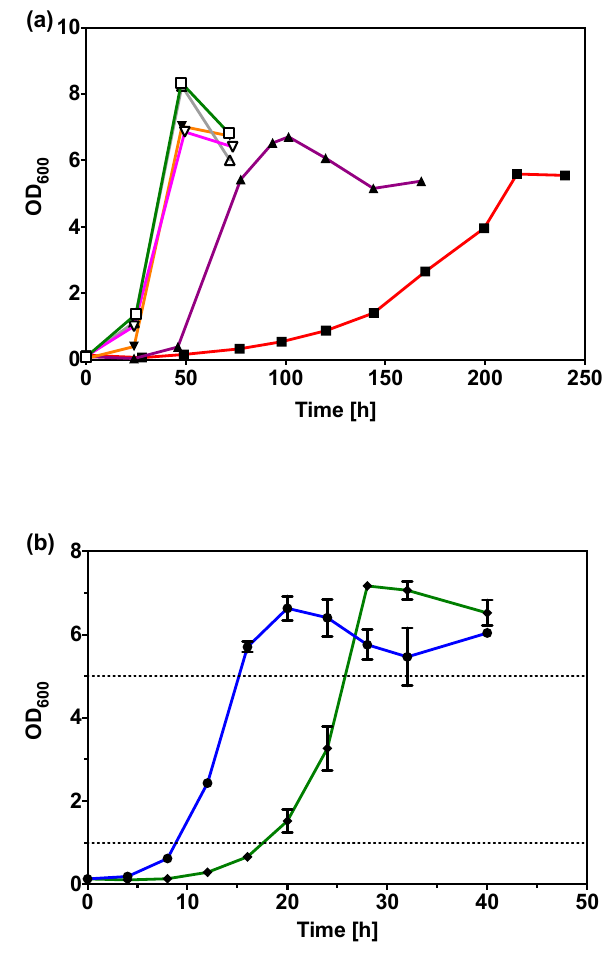
Figure 2. ( a ) Growth curves of C. necator H16 in the six serial passages during adaptive evolution; Round 1 (red line; solid square), Round 2 (purple line; solid triangle), Round 3 (orange line; solid inverted triangle), Round 4 (grey line; open triangle), Round 5 (pink line; open inverted triangle), and Round 6 (green line; open square). ( b ) Growth curve of C. necator H16 wild-type in 0.59% ( w / v ) sodium gluconate (blue line; solid circle) and v6C6 variant in 0.50% ( w / v ) glycerol (green line; solid diamond), with the dotted lines indicating OD 600 values of 1.0 and 5.0.